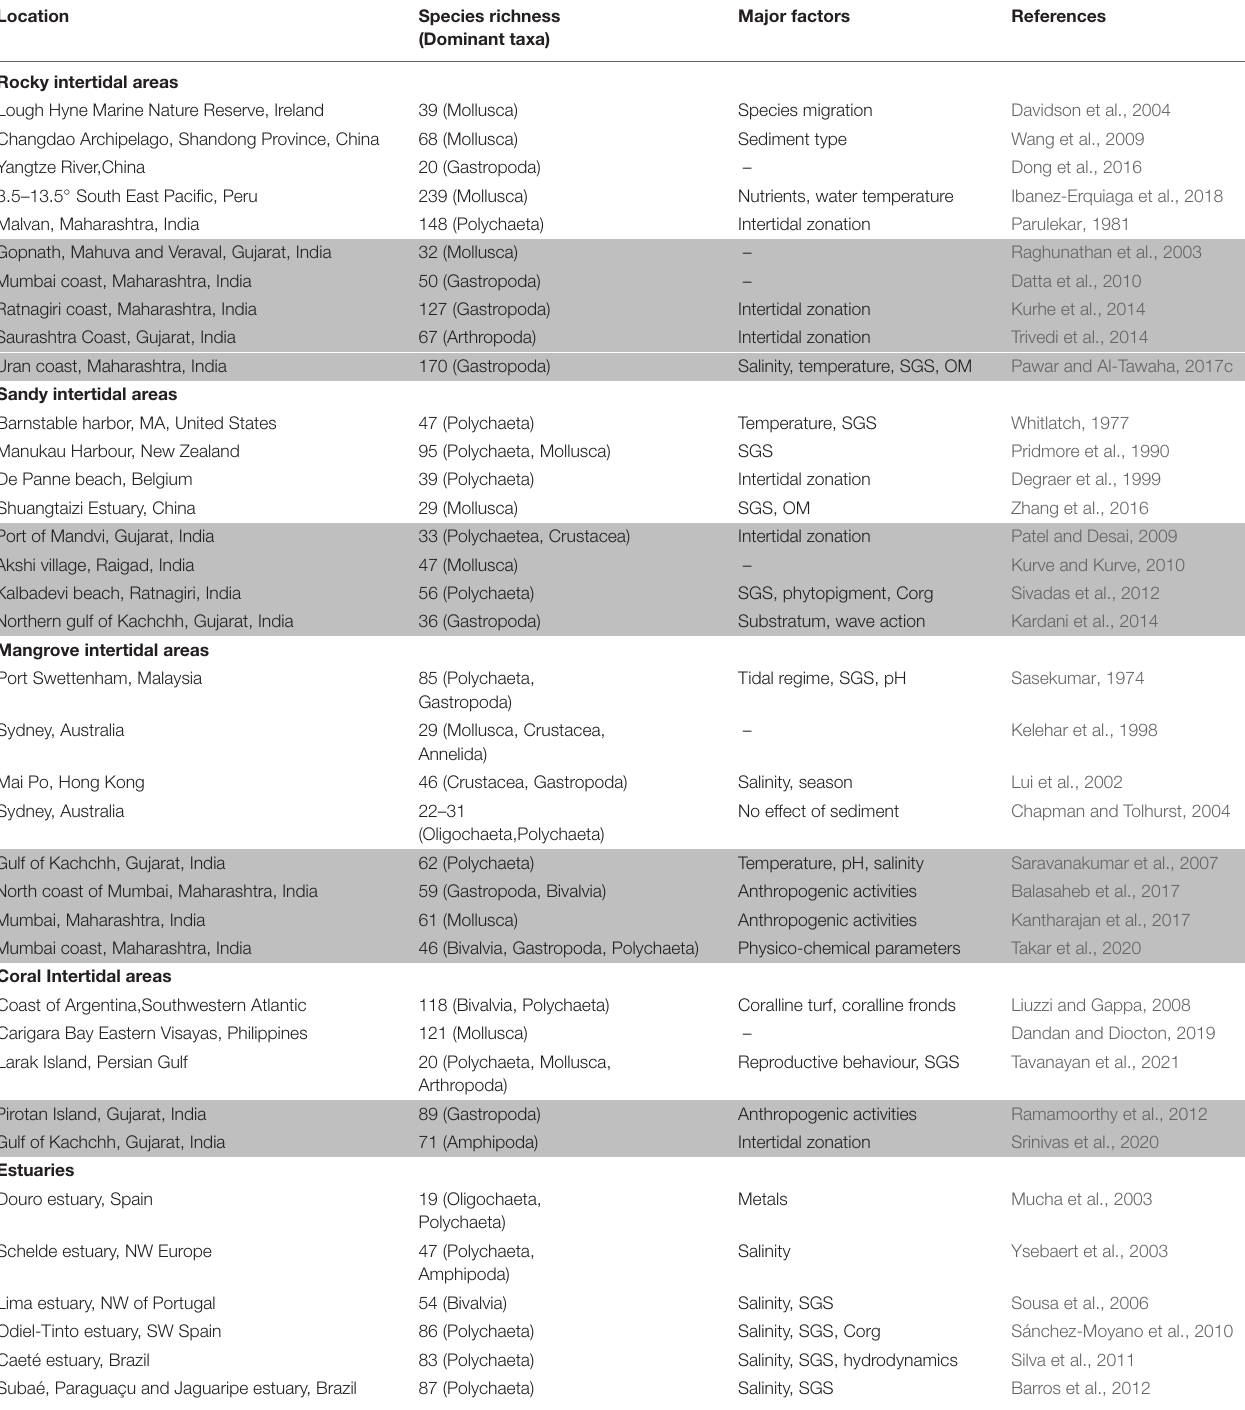
TABLE 1 | Comparison of the dominant macrobenthic taxa and major factors exerting influence on the macrobenthic community structure from some indicative studies reported elsewhere with investigations included in this review (indicated by the shaded region).